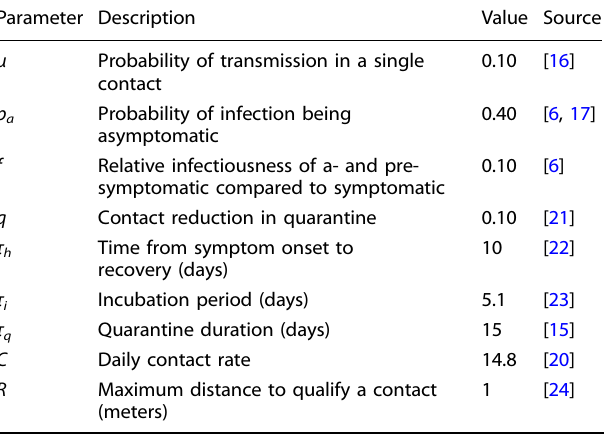
Table 2. Model parameter values and